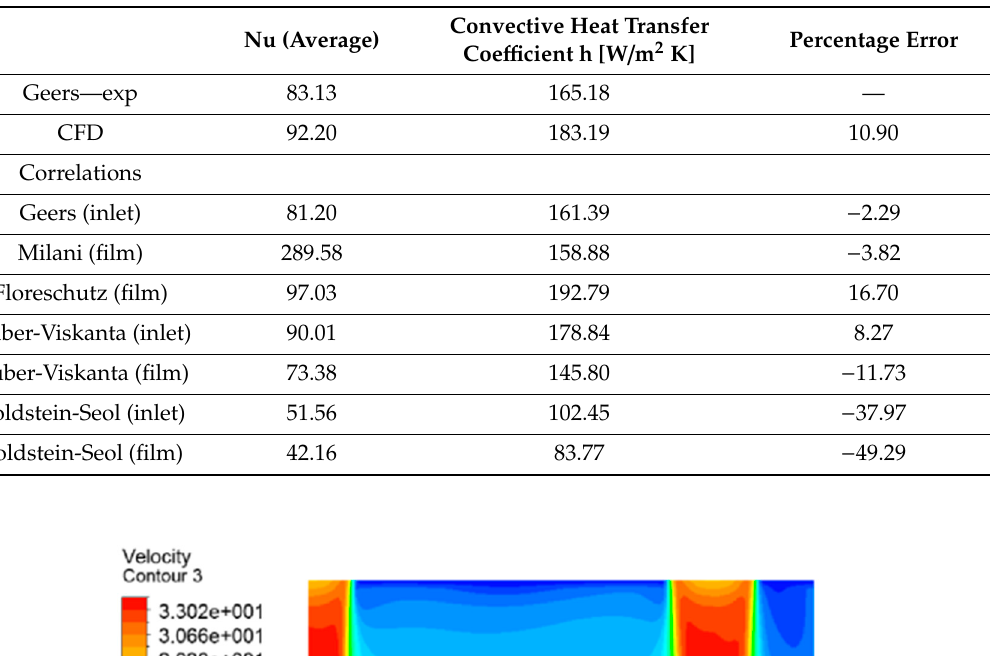
Table 1. Comparison of CFD, experimental, and numerical correlation [6] data.